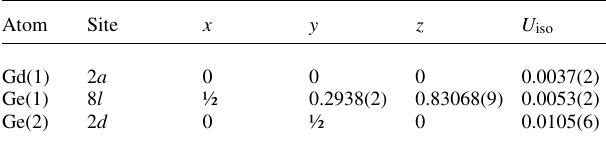
Table 2. Atomic coordinates and displacement parameters (in Å 2 )